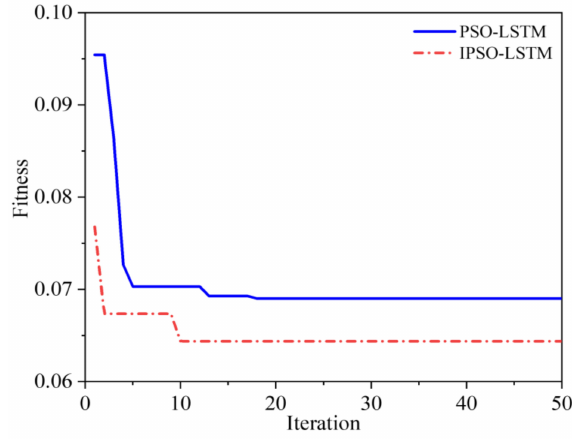
Figure 16. Optimization iteration results of roller bearing.